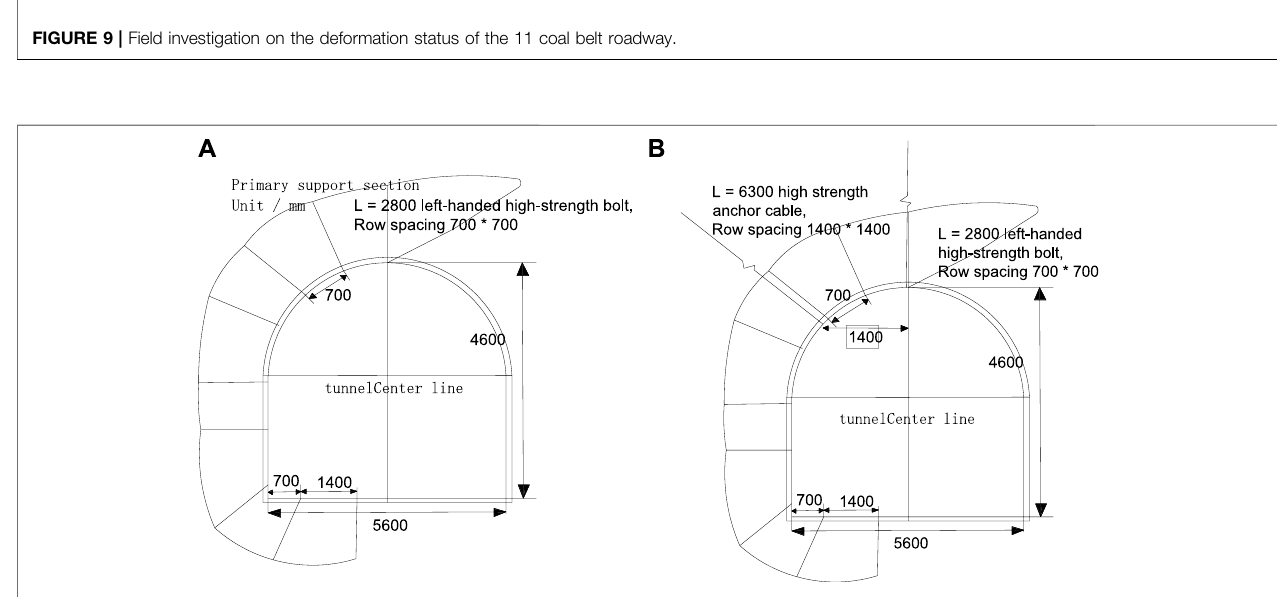
FIGURE 10 | Support section. (A) Permanent support. (B) Reinforcement